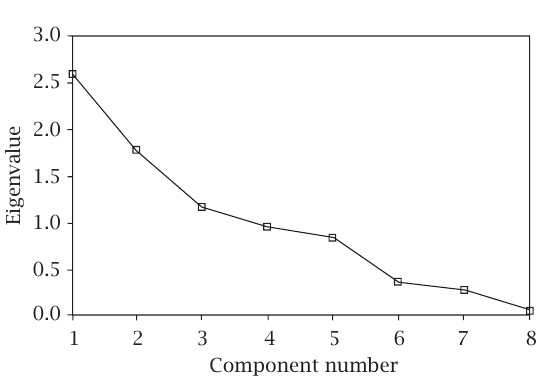
Figure 3.1 . Principal component and its eigenvalues.